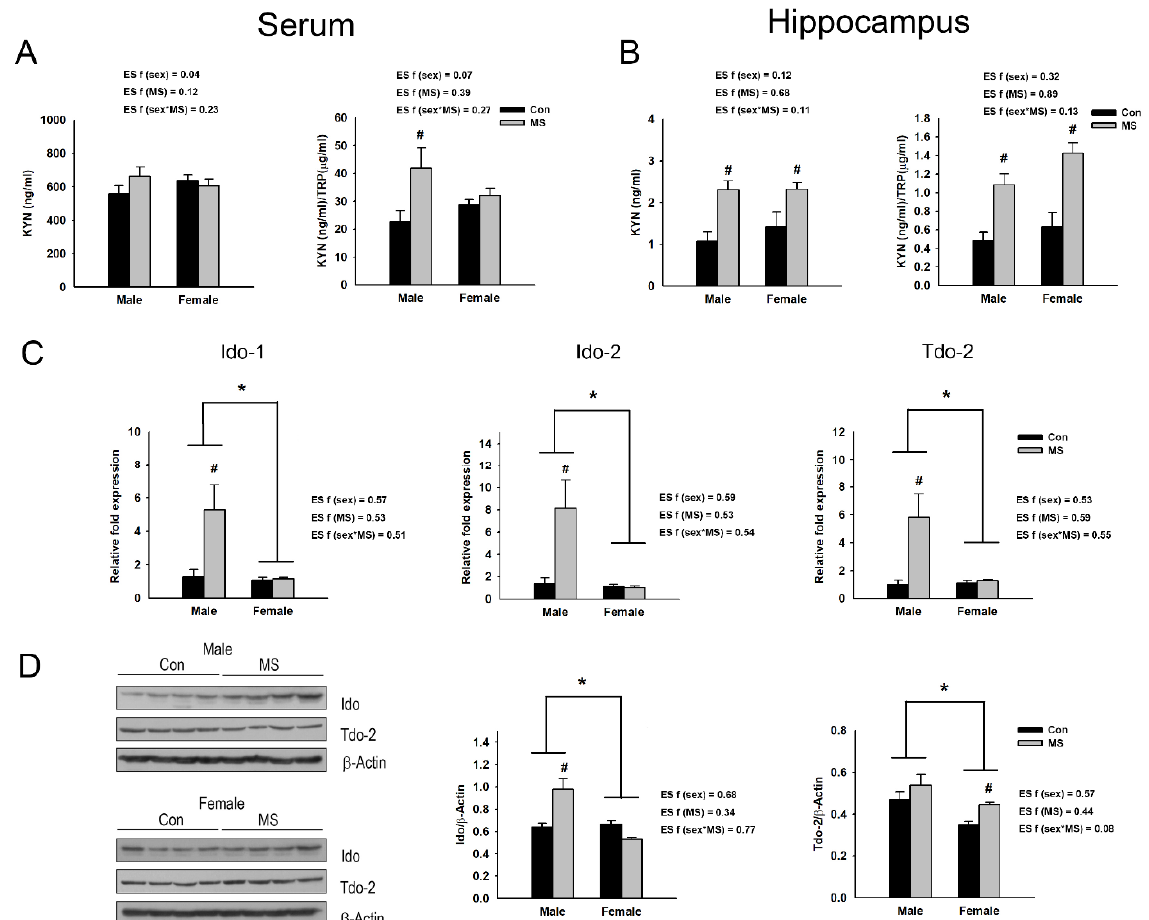
Figure 6. Effect of maternal separation (MS) on kynurenine (KYN) pathway. Kynurenine level and KYN/tryptophan (TRP) ratio are assessed in the serum ( A ) and the hippocampus ( B ) of MS rats. ( C ) The mRNA levels and ( D ) protein of indoleamine-2,3-dioxygenase-1/-2 (Ido-1/-2) and tryptophan 2,3-dioxygenase-2 (Tdo-2) in the hippocampus of male and female MS rats. Data are expressed as mean ± SEM. A two-way ANOVA test, * p < 0.05 on male vs. female; # p < 0.05 on control vs. MS within each sex. Effect size (ES) f was calculated using G*Power 3. n = 6–10 per group.